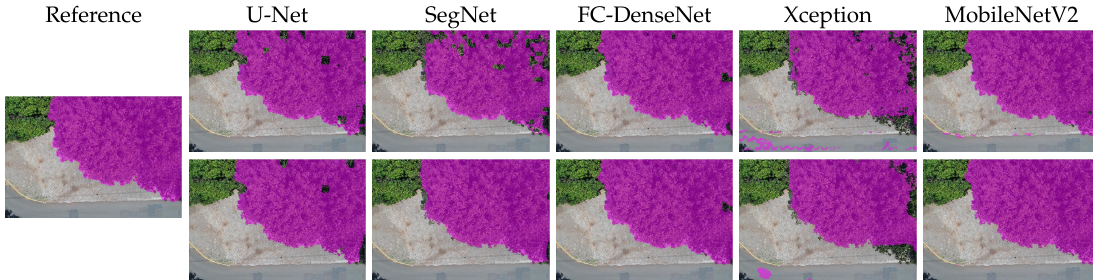
Figure 10. Sample Segmentation 1 prior (first row) and after CRF post-processing (second